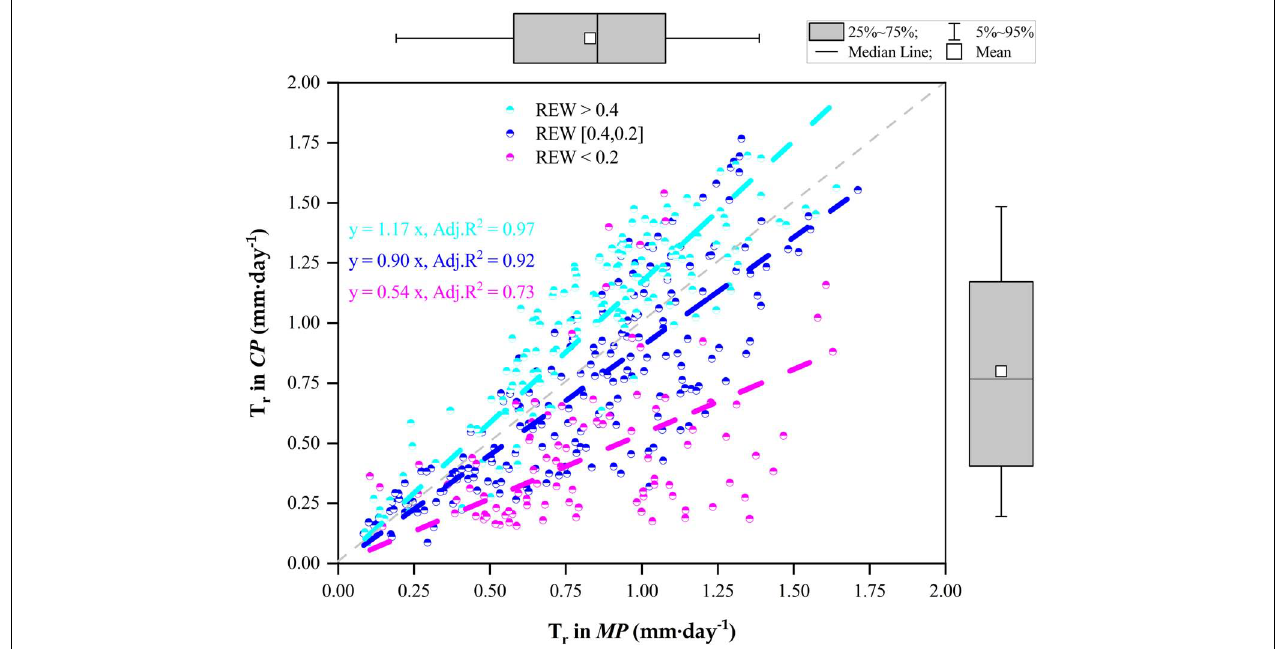
FIGURE 5 | Relationships of canopy transpiration (T r ) between Mongolian Scots pine ( MP ) and Chinese pine ( CP ) in relation to different levels of relative extractable soil water (REW).